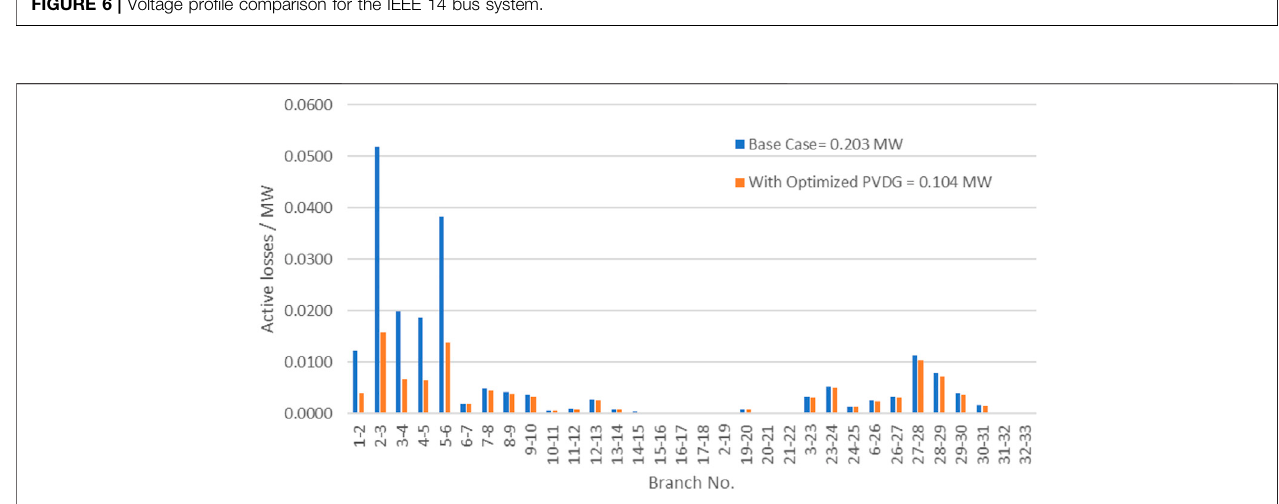
FIGURE 6 | Voltage pro fi le comparison for the IEEE 14 bus system.